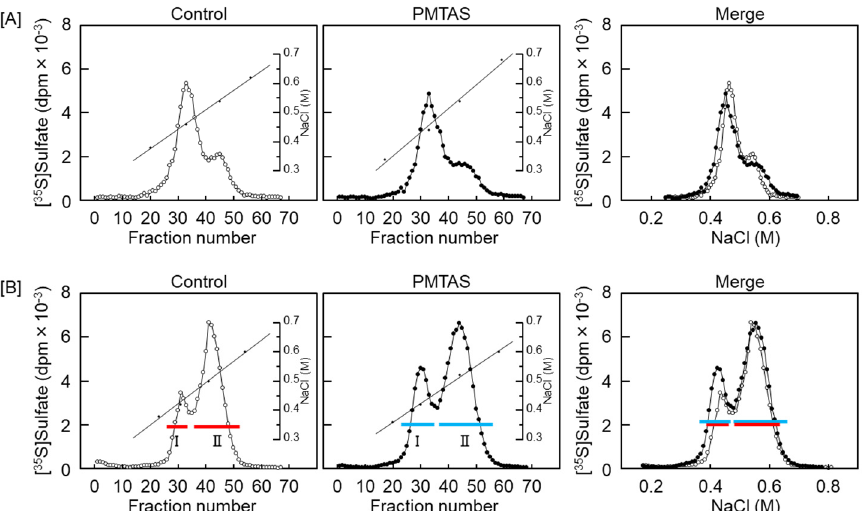
Figure 5. Characterization of proteoglycans based on negative charge density. Proteoglycan extraction from the ( A ) cell layer and ( B ) conditioned medium from dense culture of vascular endothelial cells treated with PMTAS (10 µ M) for 48 h and separated via DEAE-Sephacel anion-exchange chromatography. The fractions within the range of red and blue horizontal bars are pooled as Peak I and Peak II.